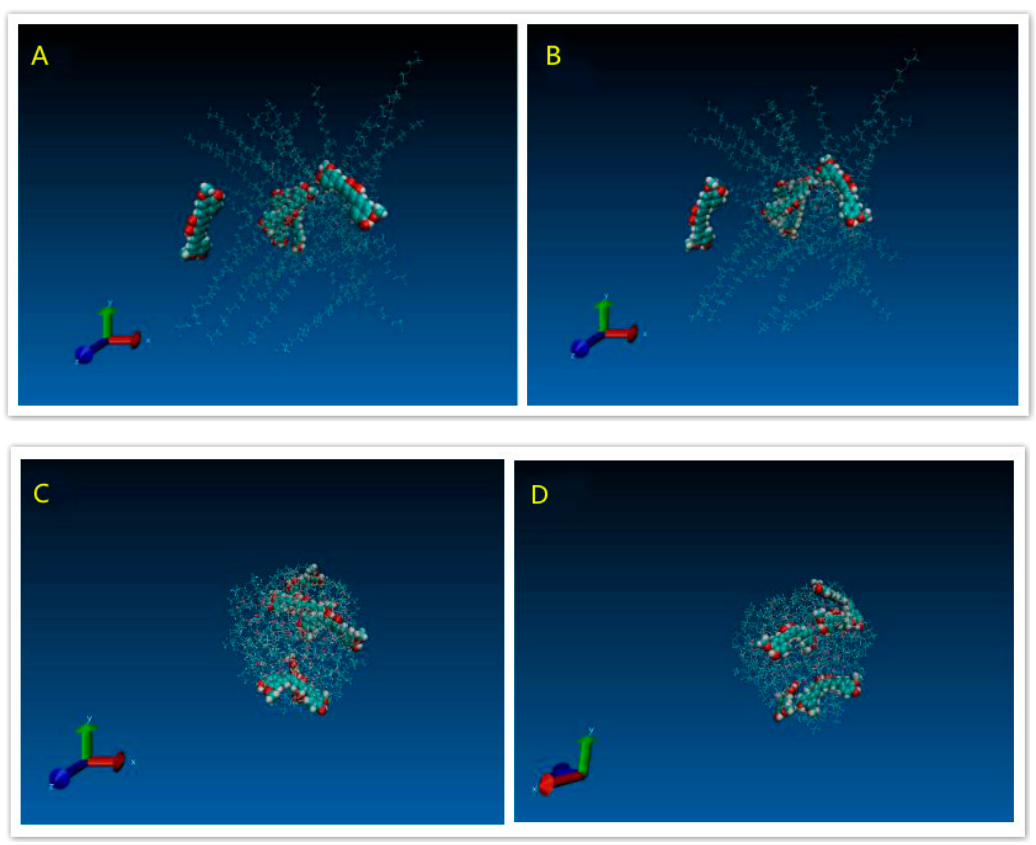
Figure 10. Snapshots of POL / Cur solid dispersion systems: ( A ) Initial structure system; ( B ) structure after minimization procedure; ( C ) system structure after 4 ns MD; and ( D ) system structure after 4 ns MD (different side).